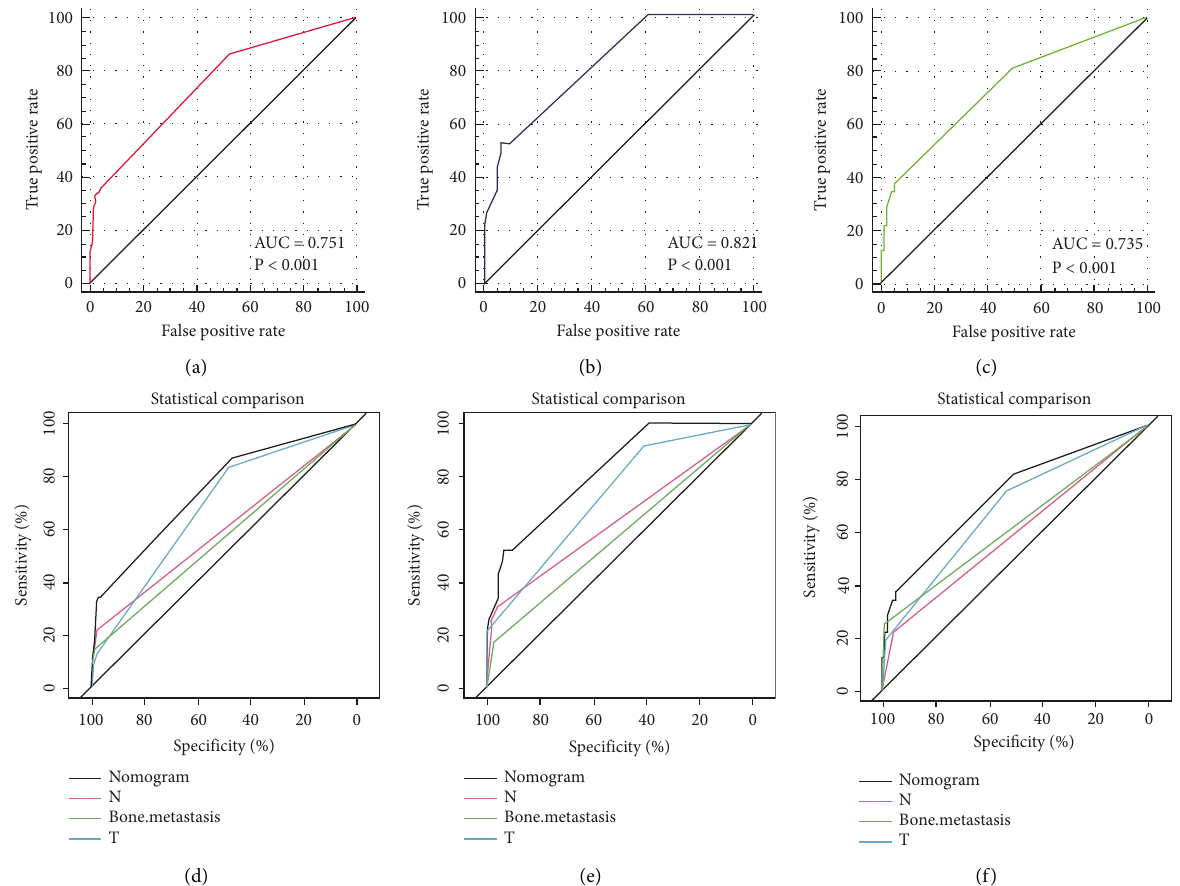
Figure 2: The receiver operating characteristic curve of the nomogram in the training set (a), internal validation set (b), and external validation set (c). Comparison of the values of the area under the curve between the nomogram and single independent risk factors in the training set (d), internal validation set (e), and external validation set